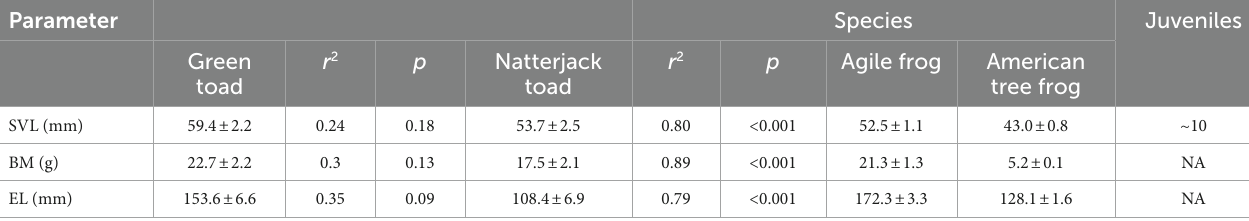
TABLE 3 Morphological parameters determined and their relationship with H eff . Parameter